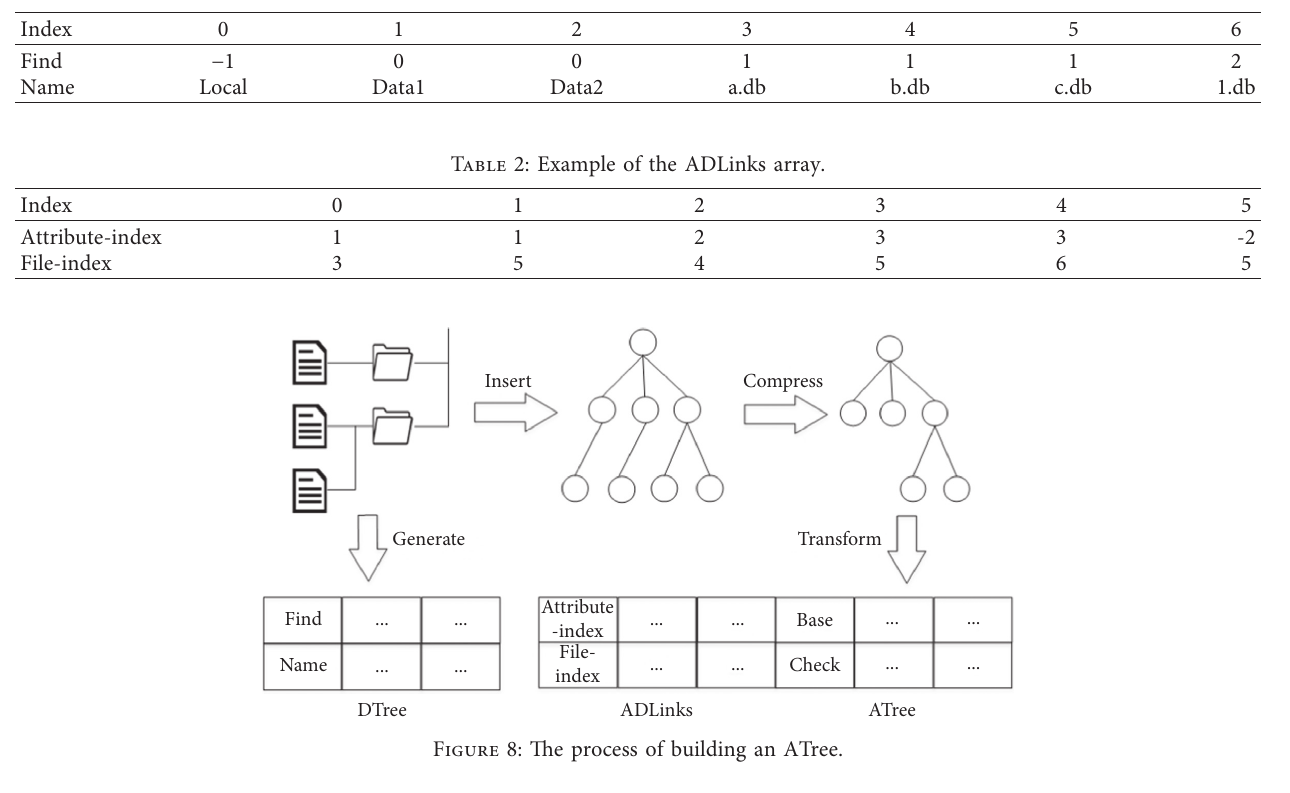
Table 1: Example of the DTree array.